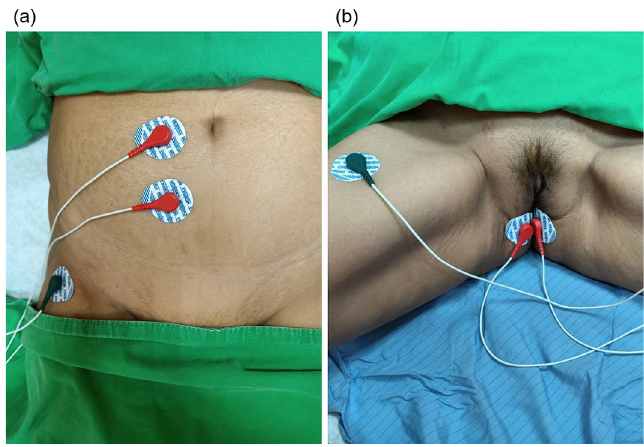
Figure 2. The application of surface 2-channel electromyography (EMG) electrodes over ( a ) abdominal rectus muscles and ( b ) perineum.